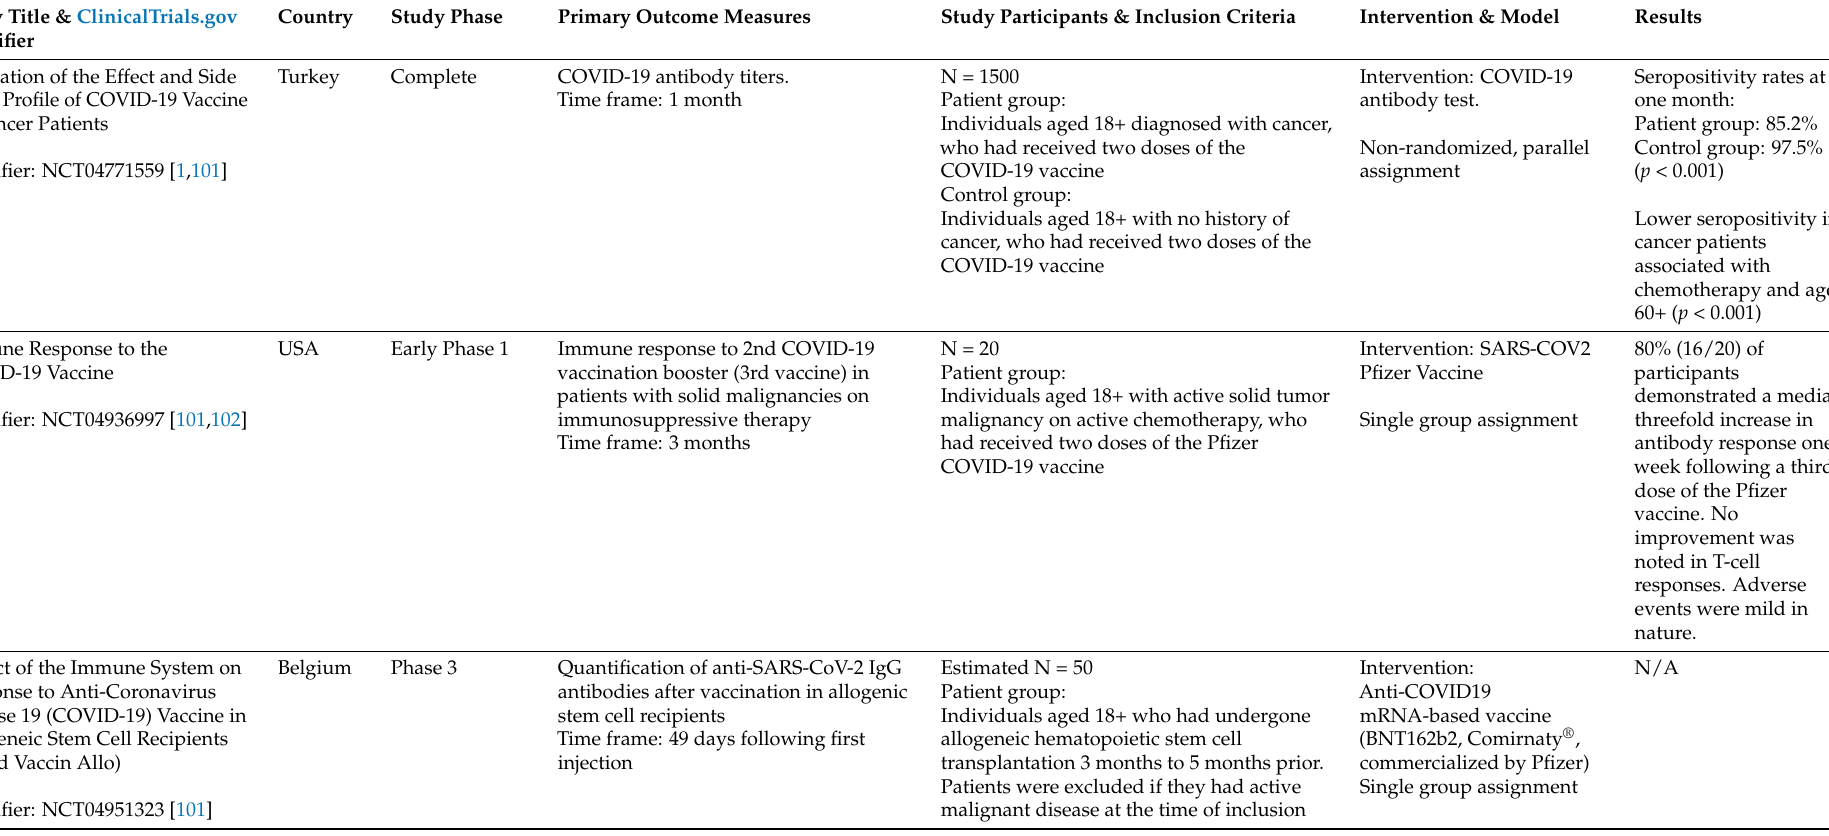
Table 1. Current Clinical Trials Investigating COVID-19 Vaccination in Patients with Cancer or Immunocompromised